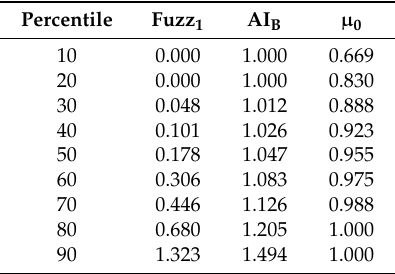
Figure 11. Crisp classification results after defuzzifying fuzzy classified objects of a WV-2 scene of Munich and their respective area coverage by applying different compound thresholds as defuzzification rules. Table 4. Percentiles for µ 0 , Fuzz 1 and AI SB measures after fuzzy re-classifying unclassified L -class objects to their according N -class.